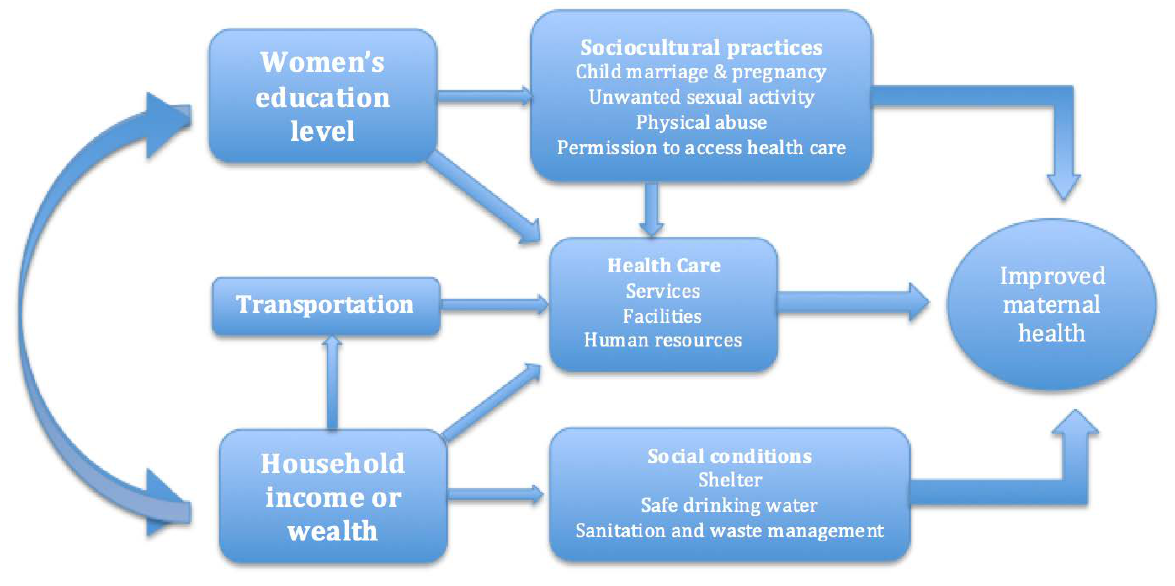
Figure 2. Pathways through which determinants influence maternal health of food (41%), shelter (18%), and clean water (14%). 9 Lack of food (malnutrition with subsequent anemia) contributes to the increased risk of complications among pregnant women. 9 Though some improvement has been made in the first decade of 21 st century, 63% of the population have no access to improved toilet facilities in 2010 and 50% were without improved water sources.